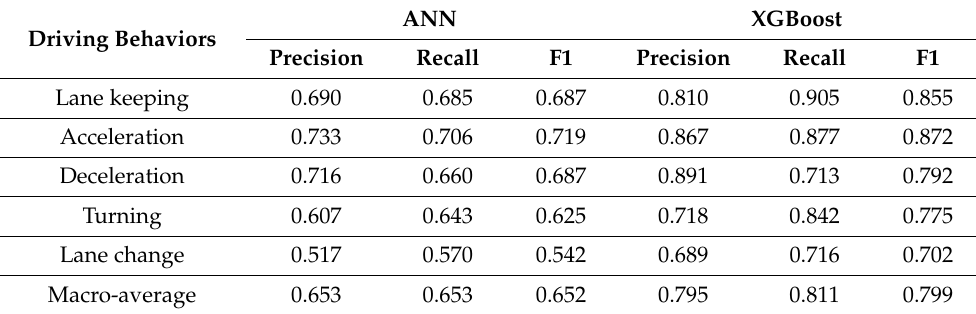
Table 6. Identification results of different